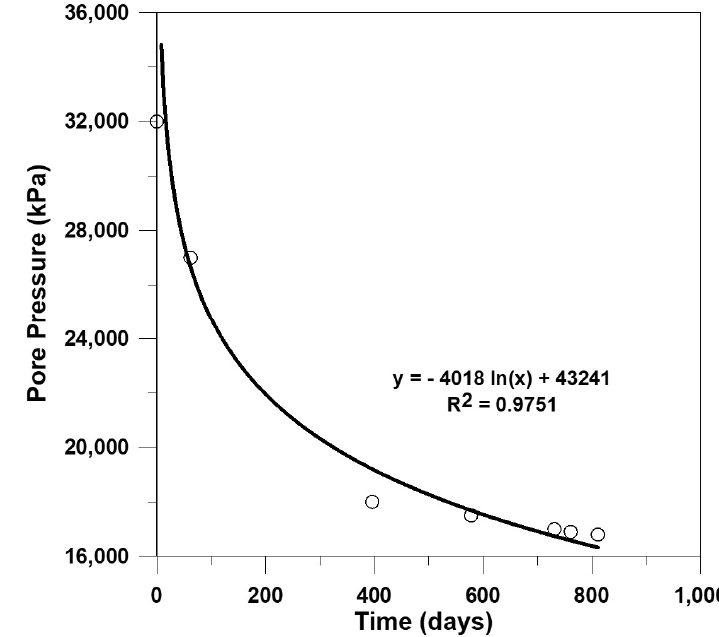
Figure 15. Average fracture fluid pressure in the flush SRV (FSRV) over